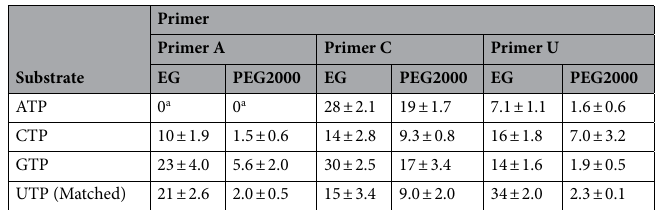
Table 4. Percentages of extended primers with NTPs at the first position next to the 3 ′ terminal of each primer in 20 wt% EG and PEG2000. a No bands for extended primers were